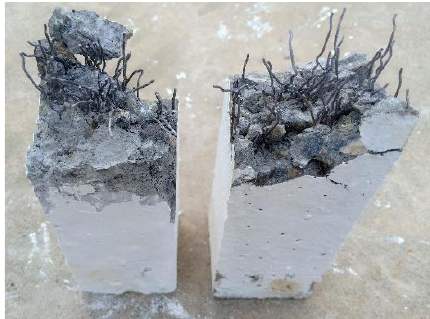
Figure 8. Failure impact energy (J2) of the three mixtures: ( a ) SB; ( b ) MB; ( c ) LB.